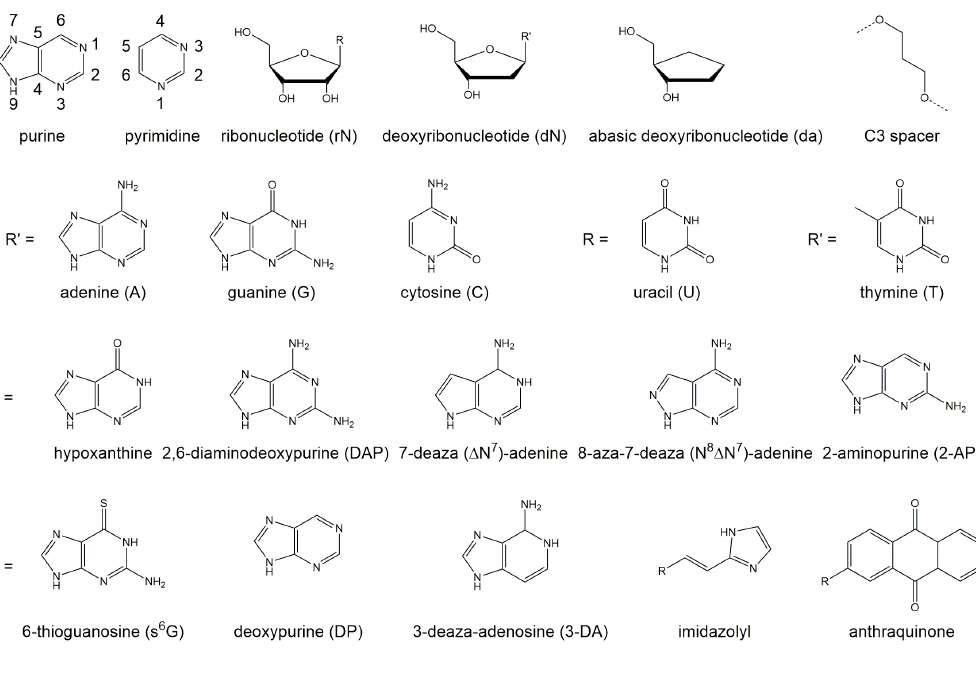
Figure 3. Structures of different nucleotides and C3 spacer used in mutagenesis studies for the 10-23 DNAzyme. The nucleobase hypoxanthine is present in the nucleotide inosine. Introduction of an intercalator between the catalytic loop deoxynucleotide dA 15 and dN − 1 of